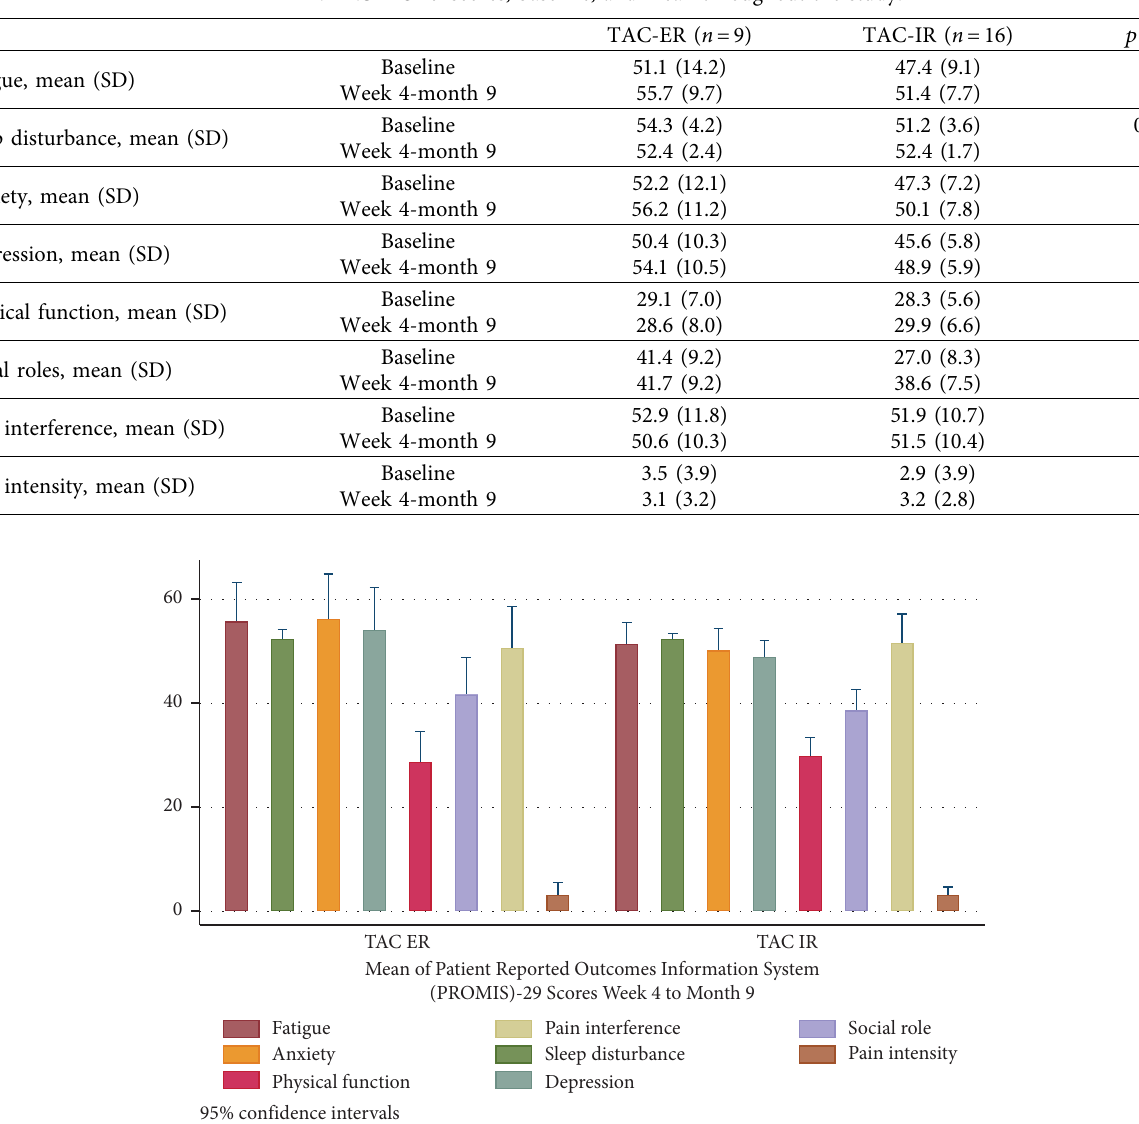
Table 2: PROMIS-29 scores, baseline, and mean throughout the study.